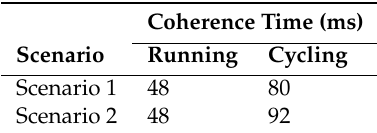
Table 1. Coherence time: Time before auto-correlation crosses the value of